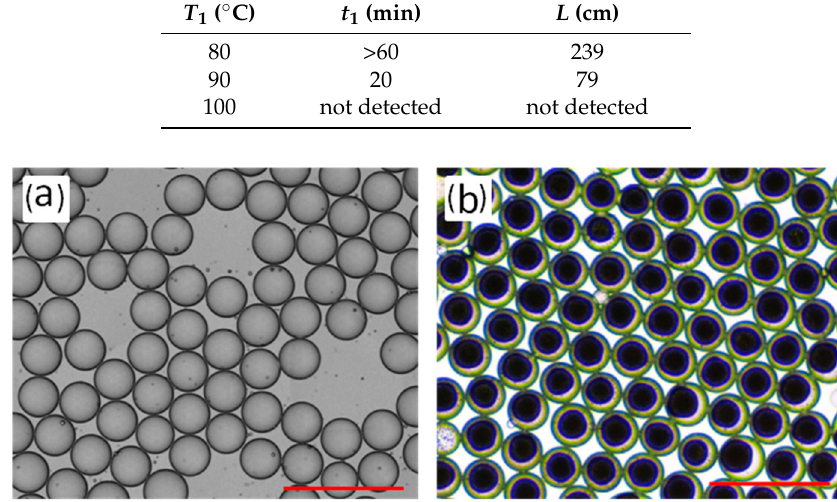
Figure 2. ( a ) Optical microscopic image of the resol emulsion droplet. ( b ) Optical microscopic image of the resol gel inside the droplet, the scale bar is 500 µm.